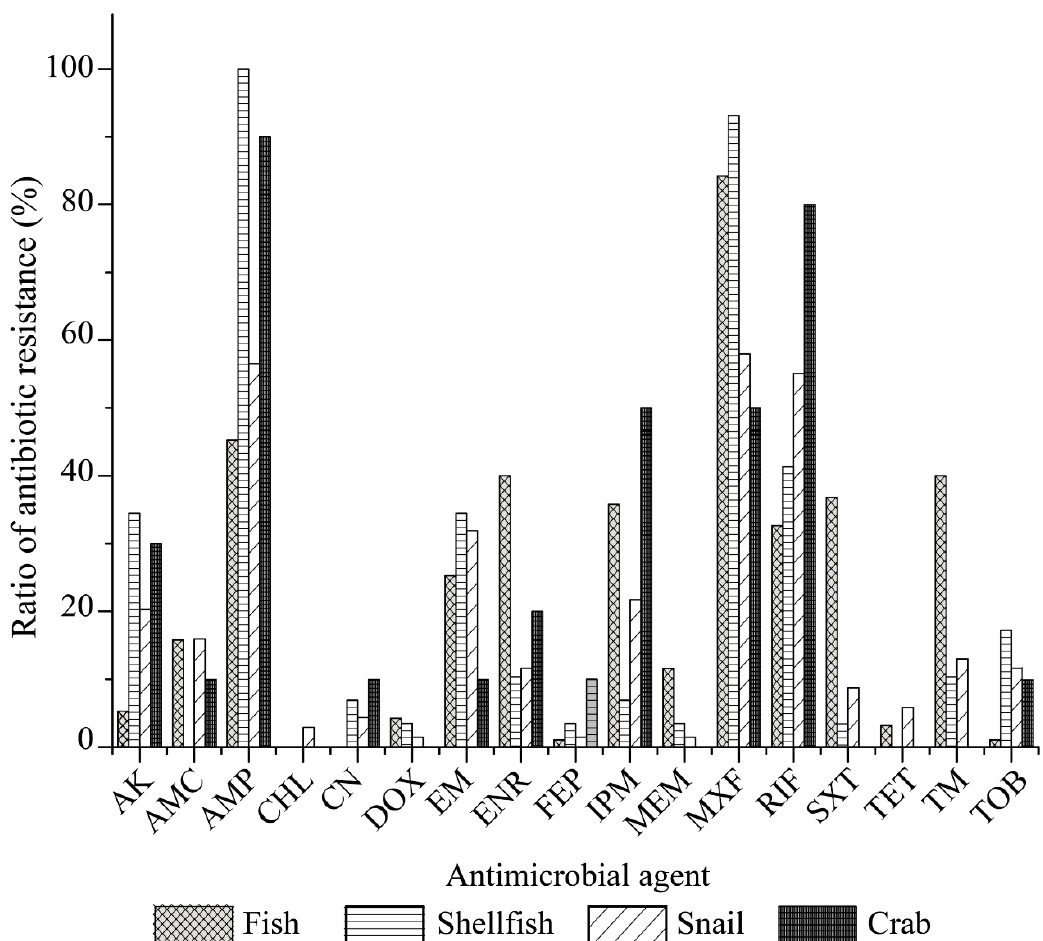
Figure 4. Antimicrobial resistance profiles of the V. cholerae isolates in the four types of aquatic food